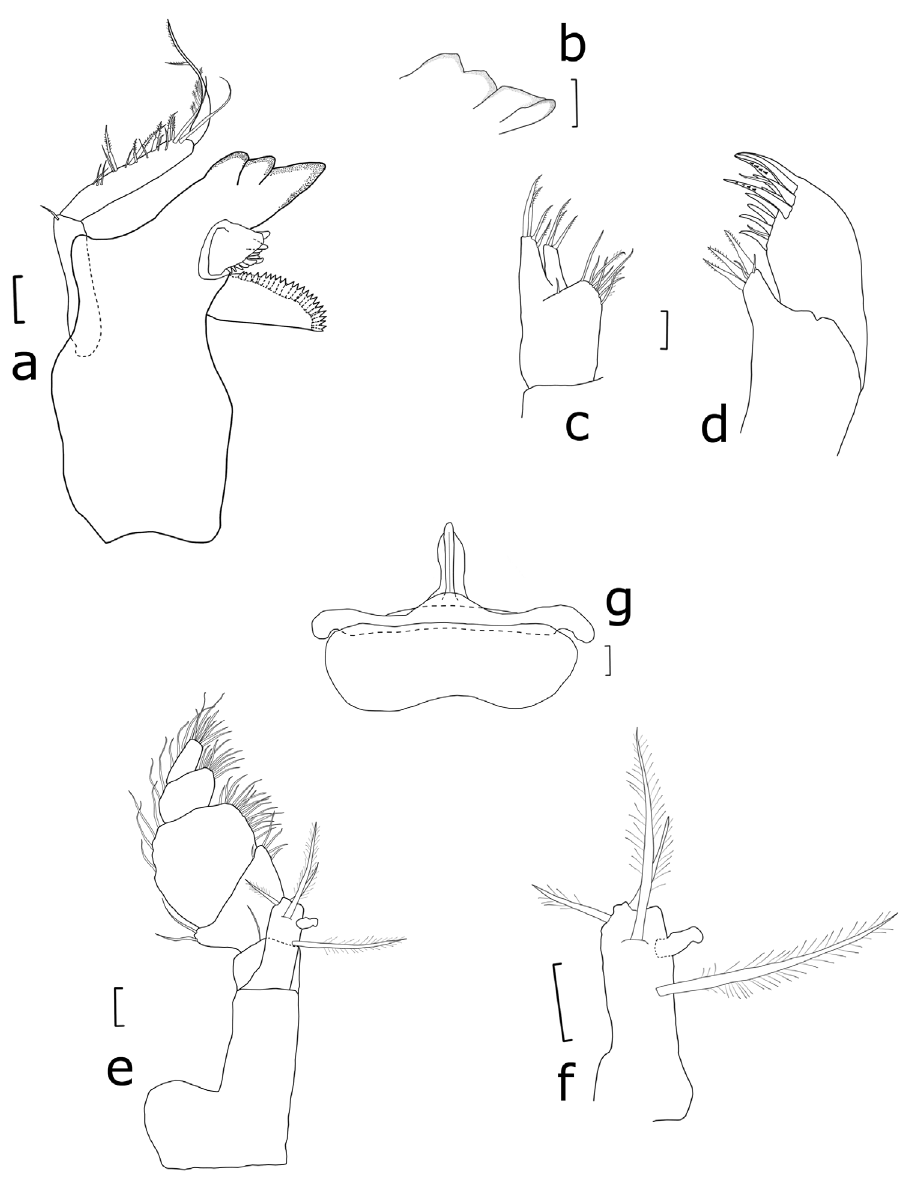
Figure 3. Typhlocirolana longimera sp. n. a right mandible b incisor, left mandible c maxilla d maxillule e maxilliped f endite of maxilliped g frontal lamina. Scale: a–g = 0.1